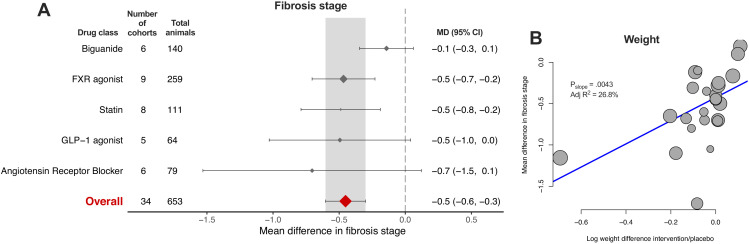
Meta-analysis of fibrosis stage in rodent studies of NAFLD.(A) Forest plot with subgrouping by class of drug. Individual studies have been hidden and only subgroup summaries are illustrated. The total number of animals is calculated from the sum of control and interventional animals for each subgroup. CI, confidence interval; FXR, Farnesoid X receptor; GLP-1, Glucagon-like peptide-1; MD, mean difference. (B) Meta-regression bubble plot using (log) difference in weight between interventional and control animals, after removal of studies using models that induce weight loss.Figure 8—source data 1.Results of meta-analysis and meta-regression of fibrosis stage in rodent studies of NAFLD.Tab 1. Results from meta-analysis of fibrosis stage with subgroup by drug class. Tab 2. Results from meta-analysis of fibrosis stage with subgroup by individual drug. Tab 3. Results from meta-analysis of fibrosis stage with subgroup by drug class, after removal of outlier studies. Tab 4. Results from univariable meta-regression analyses. Tab 5. Results from multivariable meta-regression analyses.